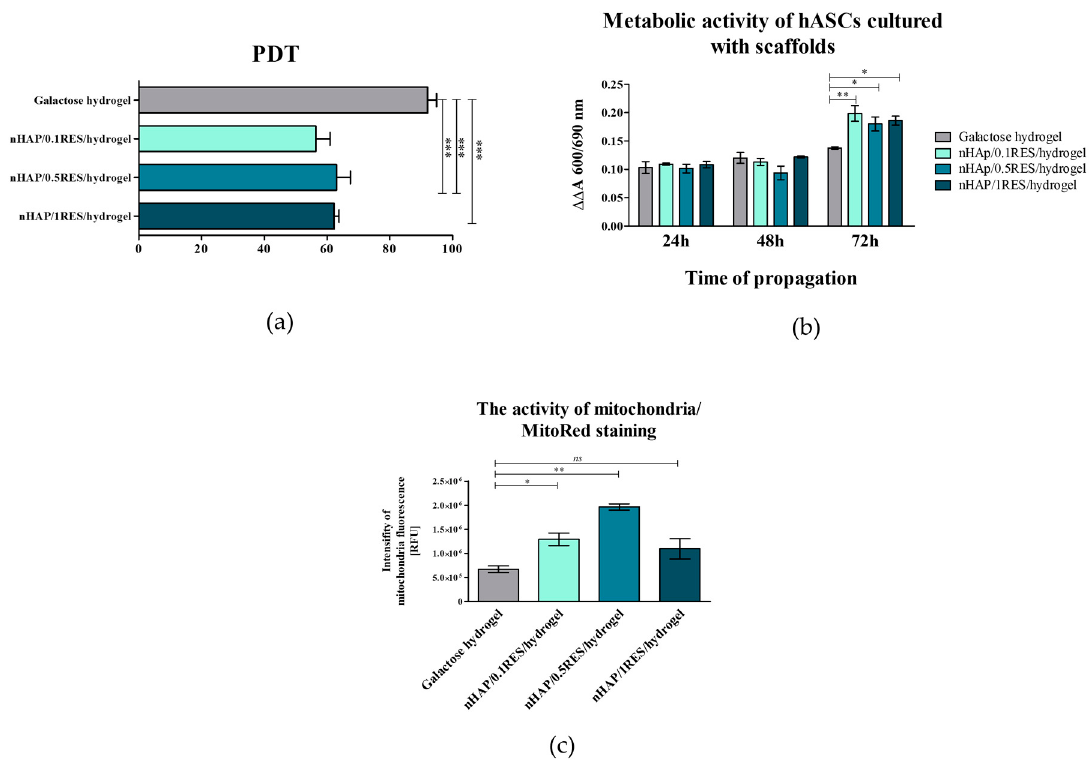
Figure 9. The influence of resveratrol/nHAp/hydrogels on hASC population doubling time ( a ), and metabolic ( b ) and mitochondrial activity ( c ). Statistically significant changes are indicated with asterisks, (*) p < 0.05, (**) p < 0.01, and (***) p < 0.001, while non-significant differences are marked as ns .